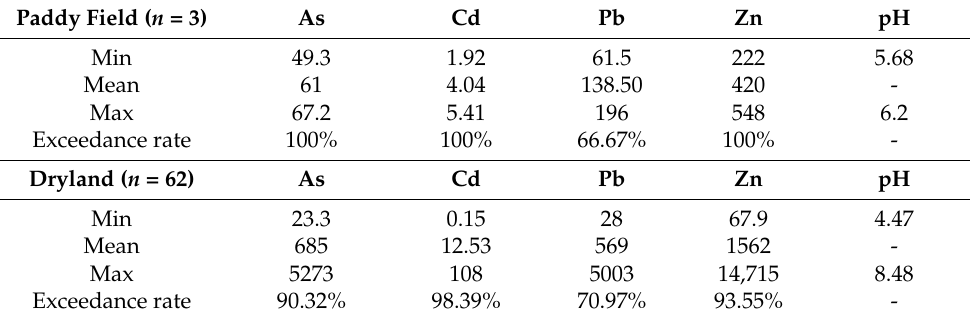
Table 4. Characteristics of heavy metals content in topsoil ( µ g/g).